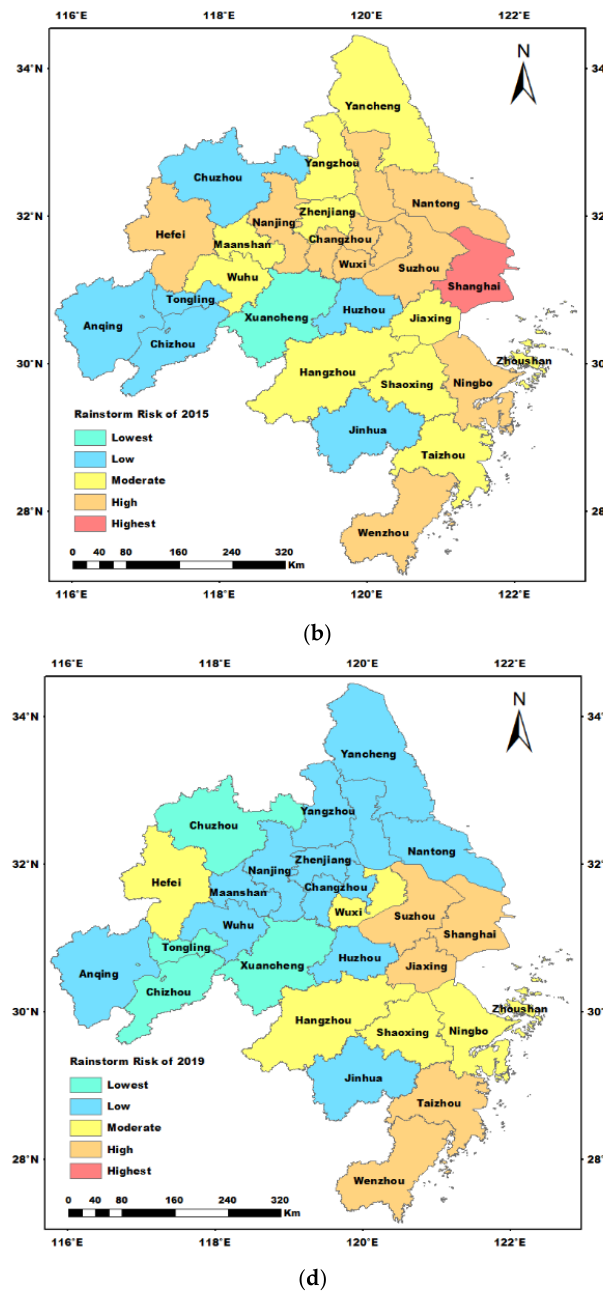
Figure 4. The projection values of 27 cities from 2011 to 2019.